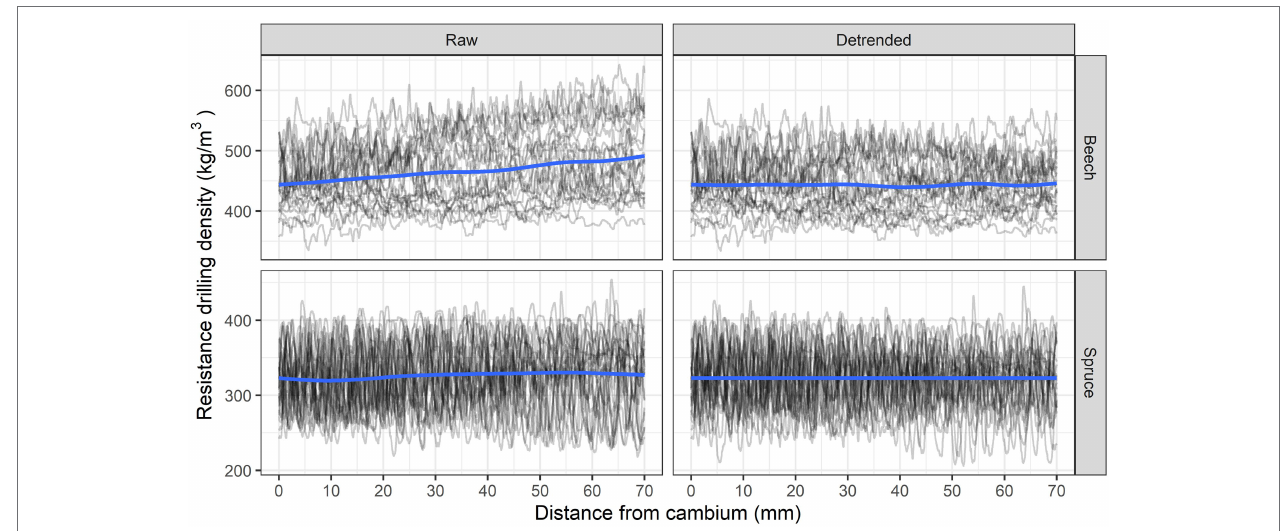
FIGURE 3 | Unadjusted (raw) and detrended debarked resistance drilling density profiles for beech and